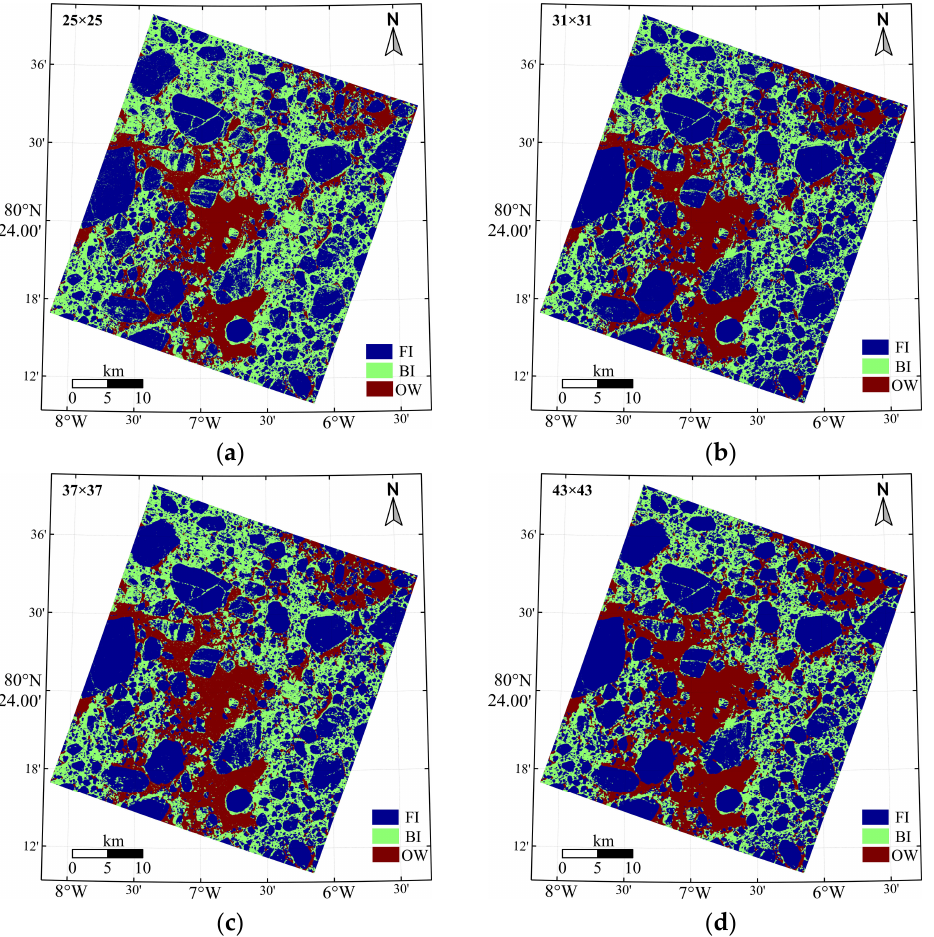
Figure 6. Sea ice classification results for the R3-15 scene using MSI-ResNet with a patch size of ( a ) 25 × 25, ( b ) 31 × 31, ( c ) 37 × 37, and ( d ) 43 × 43. Table 2. Sea ice classification confusion matrix for the R3-15 scene data based on MSI-ResNet with patch sizes of 25 × 25, 31 × 31, 37 × 37, and 43 × 43.